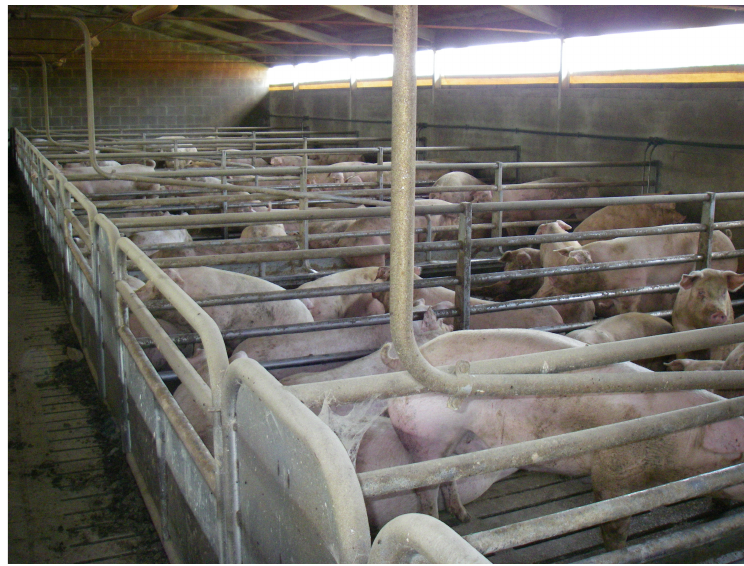
Fig. 3 Fattening unit, with several animals in each